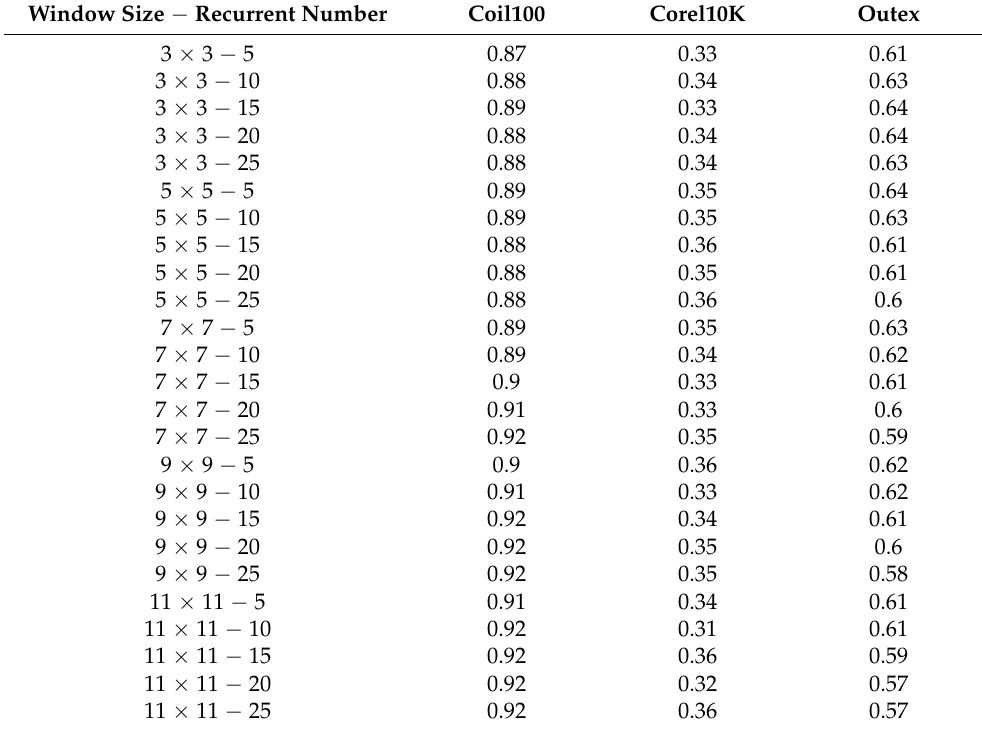
Table 3. Accuracy results for various window sizes and transformations for the three datasets using NB. Window Size − Recurrent Number